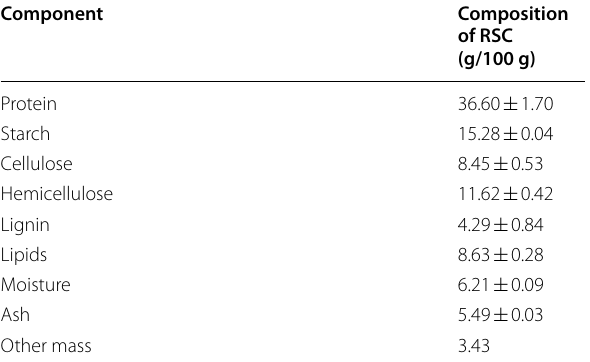
Table 2 Composition of rubber seed cake (RSC) Component